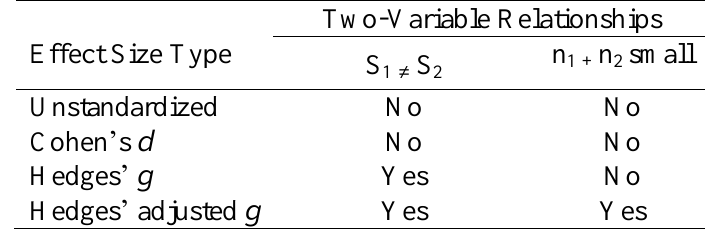
Summary of the effect size statistics Two-Variable